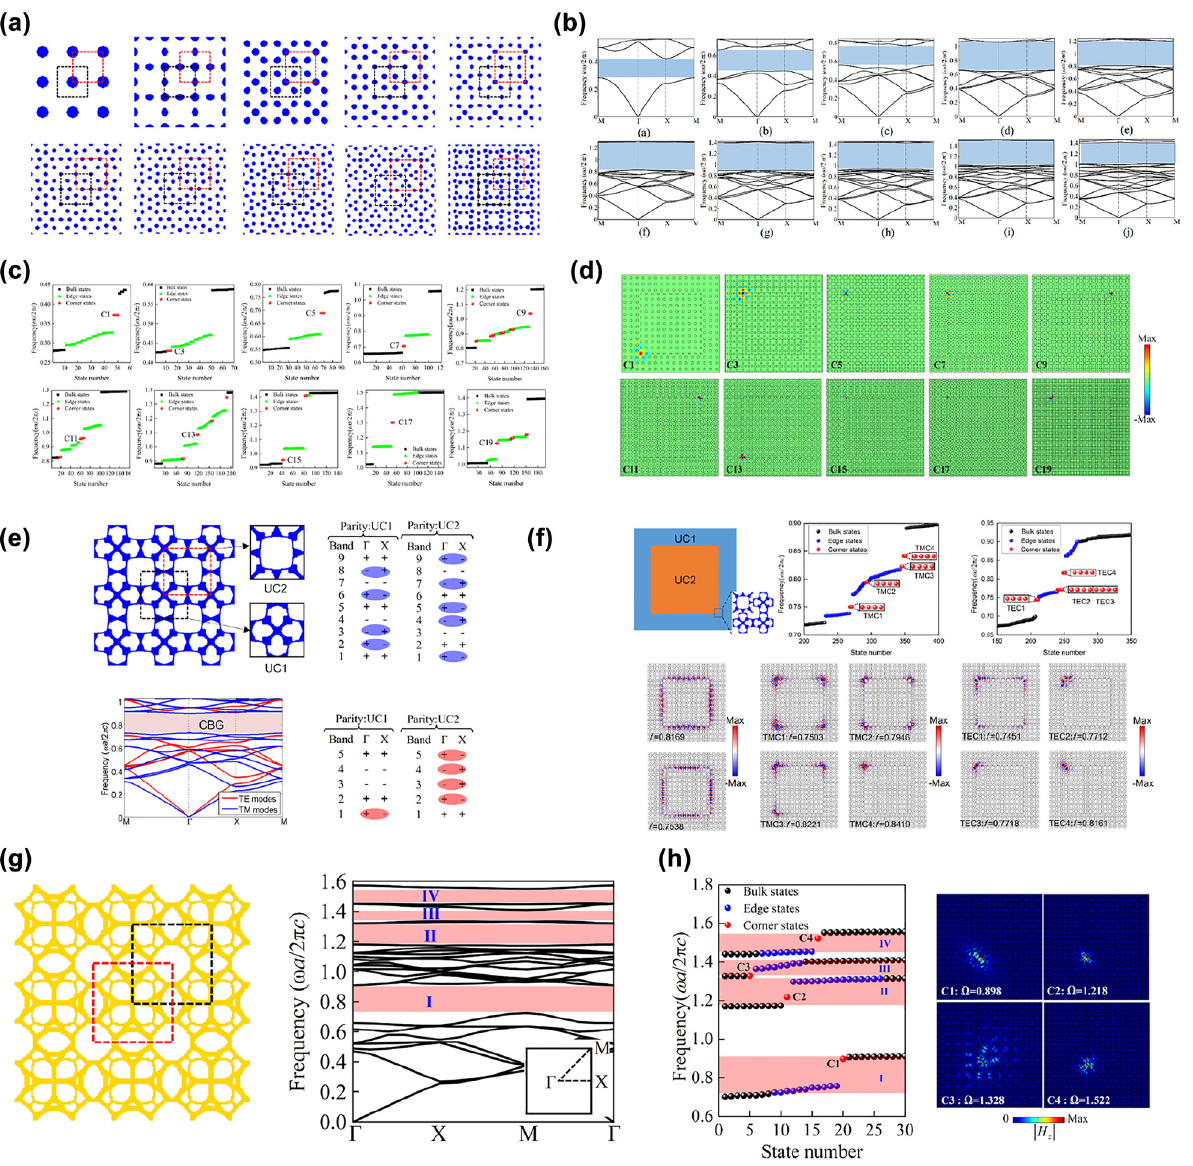
Figure 4: Inverse-designed second-order photonic TIs. (a) Optimized photonic crystals with odd-order bandgaps in Ref. [110]. (b) Band diagrams of optimized photonic crystals with odd-order bandgaps in Ref. [110]. (c) Calculated eigenfrequency spectrum of the second-order photonic TIs in Ref. [110]. (d) Eigenfield distributions of the corner states in Ref. [110]. (e) Optimized photonic crystal with dual-polarization bandgaps in Ref. [111]. (f) Observed dual-polarization corner states in Ref. [111]. (g) Optimized photonic crystal with four bandgaps in Ref. [112]. (h) Observed multiband corner states in Ref.